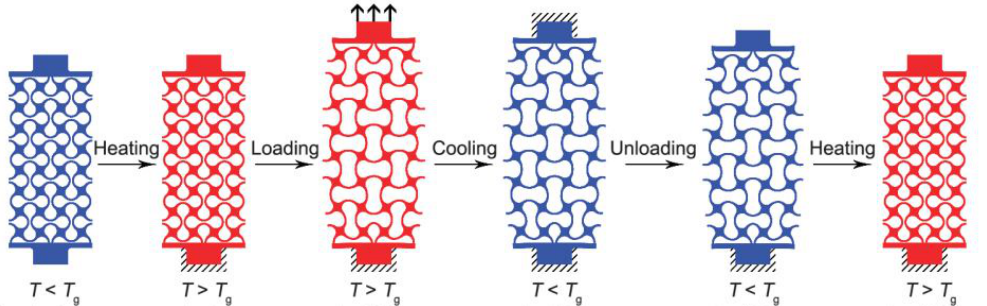
Figure 10. Schematic illustrating the thermo-mechanical loading cycle under tensile mode for shape memory polymer (SMP). Reprinted with permission from Ref. [120]. Copyright 2022,